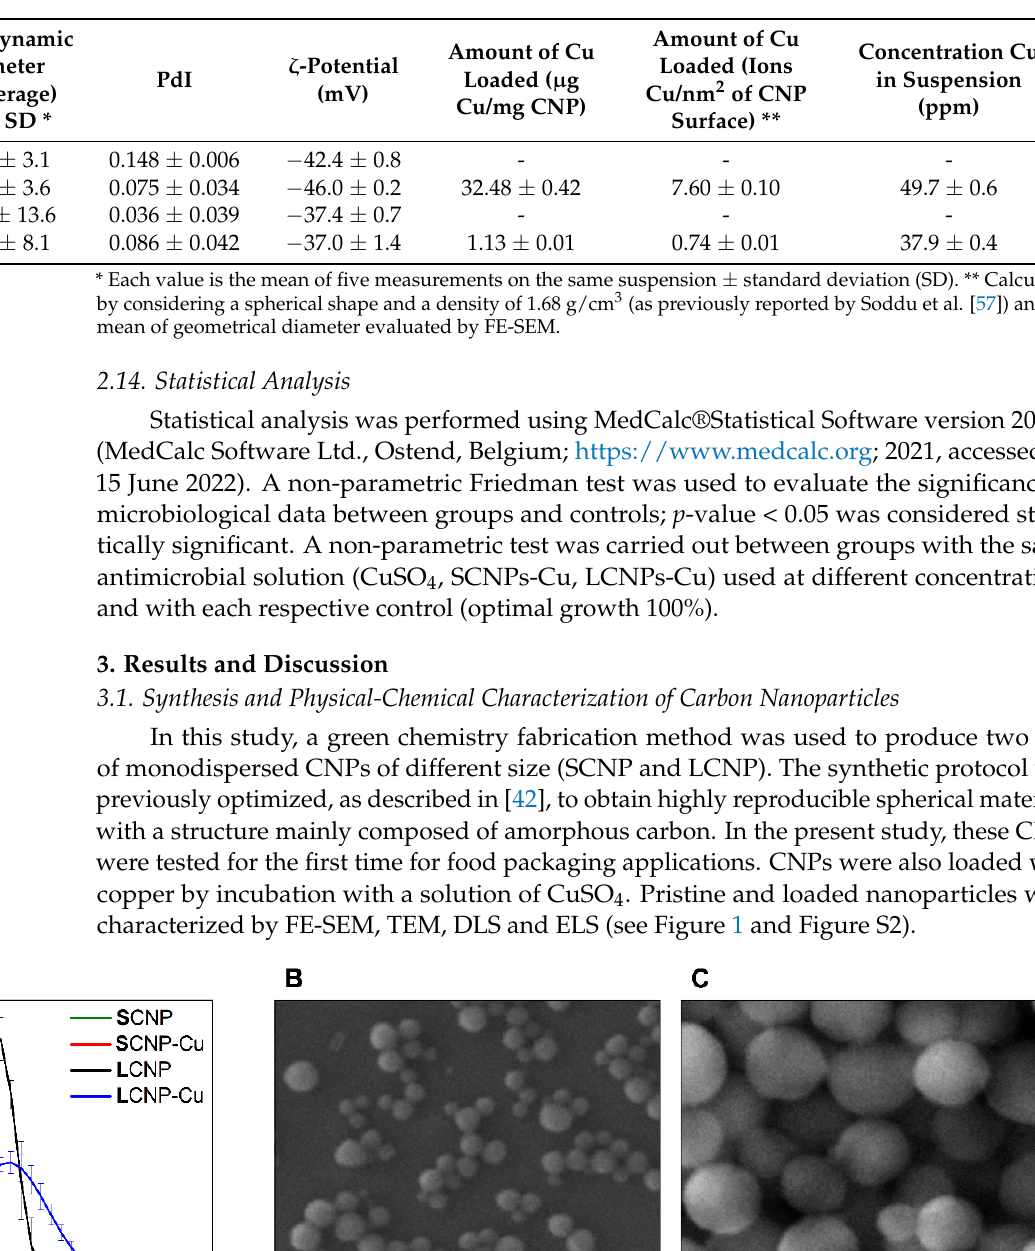
Table 2. Properties of the colloidal suspensions of pristine and Cu-loaded CNPs.